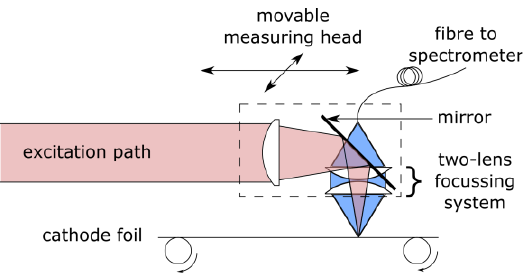
Figure 1. Inline-capable ns-LIBS measurement setup. Red: optical excitation path for 1064 nm Nd:YAG laser with active Q-switch, blue: optical detection path (behind excitation path) with two- lens collimating and refocusing system which couples the optical emission into a fiber. Both optical paths share the same focus point.